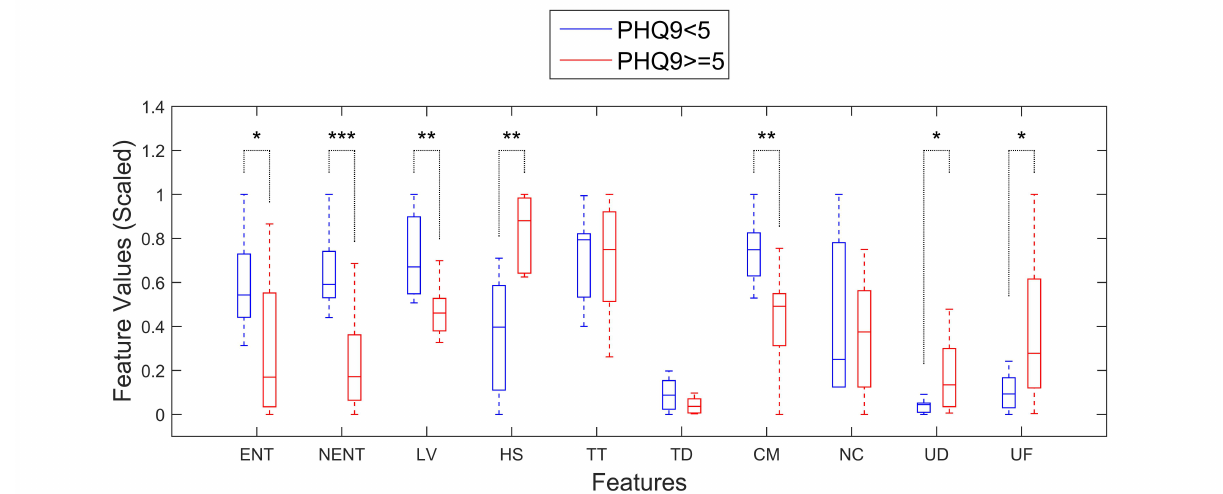
Figure 4. Comparison of location and usage feature statistics between participants with no symptoms of depression (blue) and the ones with (red). Feature values are scaled between 0 and 1 for easier comparison. Boxes extend between 25th and 75th percentiles, and whiskers show the range. Horizontal solid lines inside the boxes are medians. One, two, and three asterisks show significant differences at P <.05, P <.01, and P <.001 levels, respectively (ENT, entropy; ENTN, normalized entropy; LV, location variance; HS, home stay; TT, transition time; TD, total distance; CM, circadian movement; NC, number of clusters; UF, usage frequency; UD, usage duration).